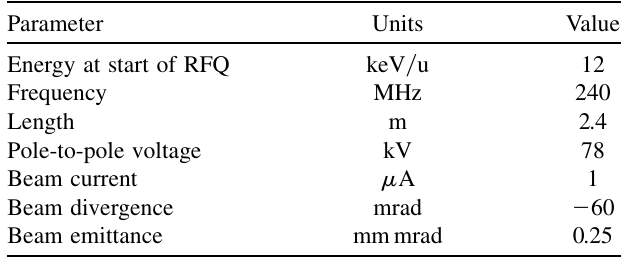
TABLE XIV. Input parameters for C 6 þ RFQ simulations.